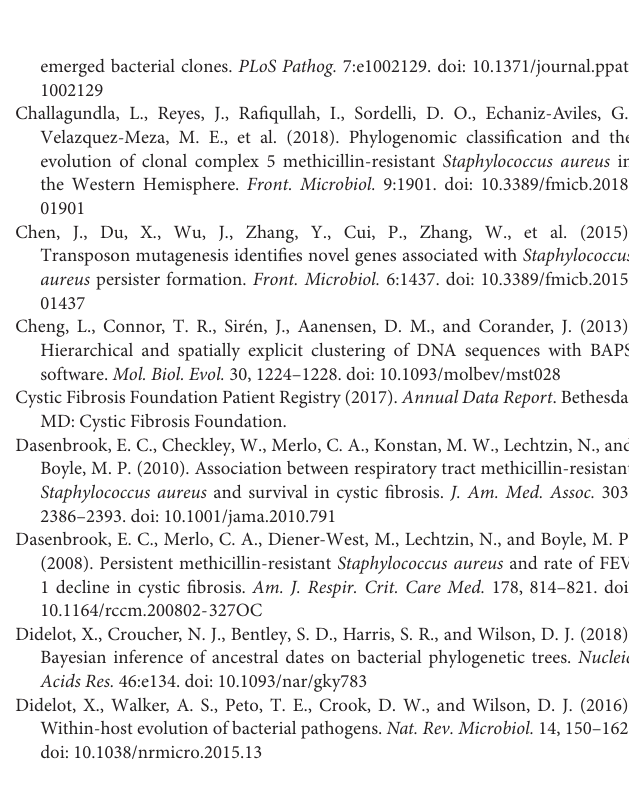
distance to determine temporal signal. Note the significant range in intrahost diversity observed between pairs of isolates collected on the same day. FIGURE S2 | Distribution of allele frequencies among clonal intrahost populations. The plots are symmetrical and only include the intrahost isolates without reference to illustrate mutations that were intermediate or fixed in the population. For example, Patient 2 has a higher density of intermediate frequency mutations than Patient 4, the effects of which can be seen in the maximum likelihood phylogenies ( Figure 2 ). FIGURE S3 | Mean pairwise SNP differences among isolates collected on the same day grouped by patient. The number same-day isolate pairs, mean, estimates, and standard errors (SE) are given for each patient. Overall, Patient 4 (Pt4) had significantly higher diversity among same-day pairs then other patients. FIGURE S4 | Maximum likelihood core genome phylogenies (left) with best-fit root based on root-to-tip correlation (right) of collection date and genetic distance. Raw mutation rate in SNPs/genome/year (Rate), most recent common ancestor in years (MRCA), correlation coefficient (R2), and significance test (p) are given at the top of each figure. Isolates are dated based on the day of collection relative to the collection date of the first isolate (day 0). Therefore, clonal populations may have MRCA dates > 0 (e.g., Patient 1). FIGURE S5 | Diversity (Watterson’s (cid:127) ) at 0-fold and 4-fold degenerate sites for each patient. The boxplot shows the distribution of 0-fold vs. 4-fold (cid:127) values by patient, among clusters of orthologous groups (COGs) which (cid:127) could be calculated at 0-fold (strictly non-synonymous) and 4-fold (synonymous) degenerate sites. TABLE S1 | List of isolates, BioSample accession numbers, metadata, molecular typing, and genome assembly statistics. TABLE S2 | List of clusters of orthologous groups (COGs) variable in two or more patients. Each COG is annotated using the NCBI locus tag for reference strain BUSTED analysis are included for COGs for which the test statistic could be